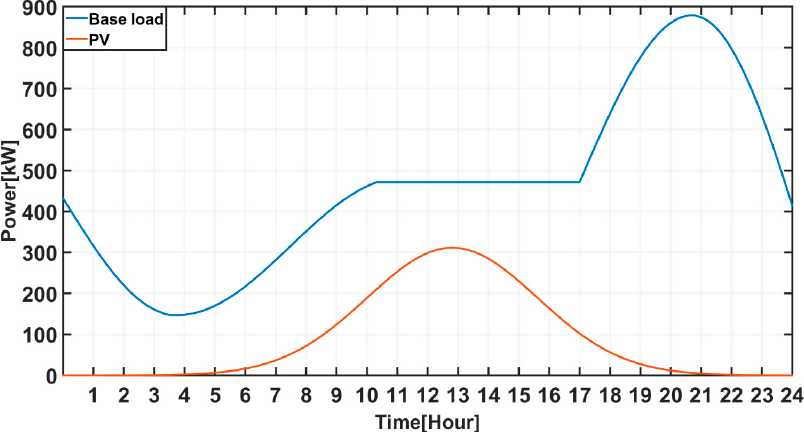
Figure 6. Local map of the considered apartment complex.